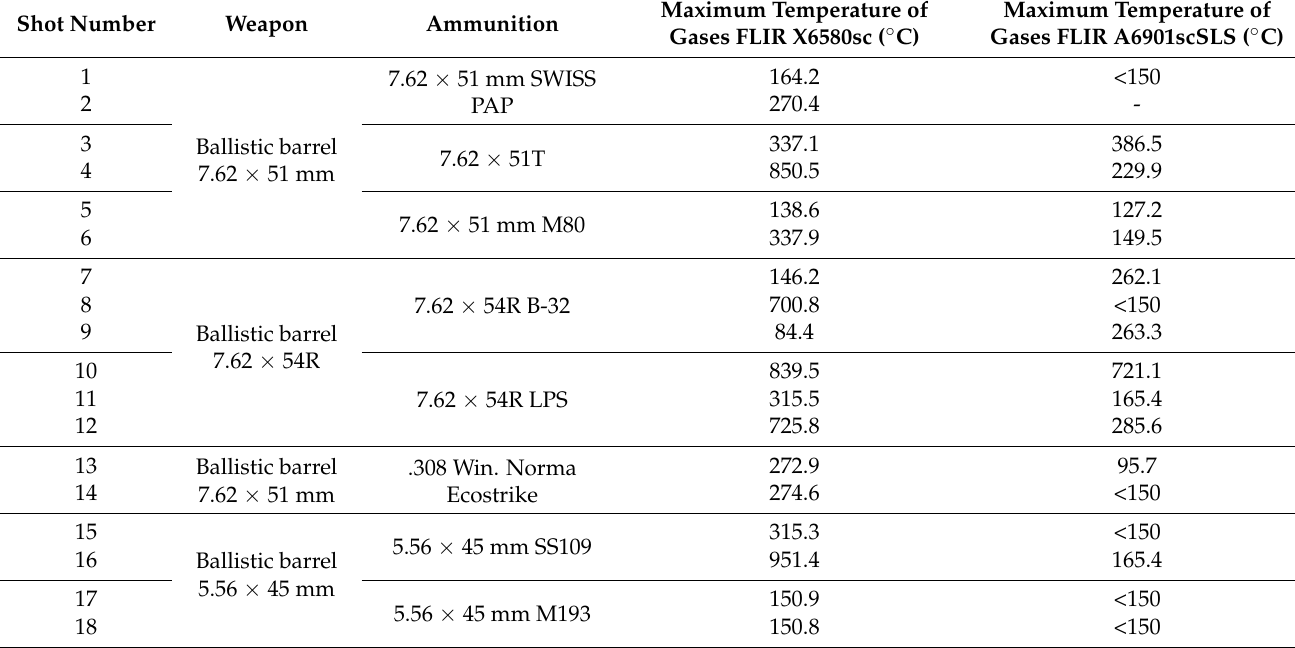
Table 1. Maximum projectile ricochet temperatures on the armour plate Armox